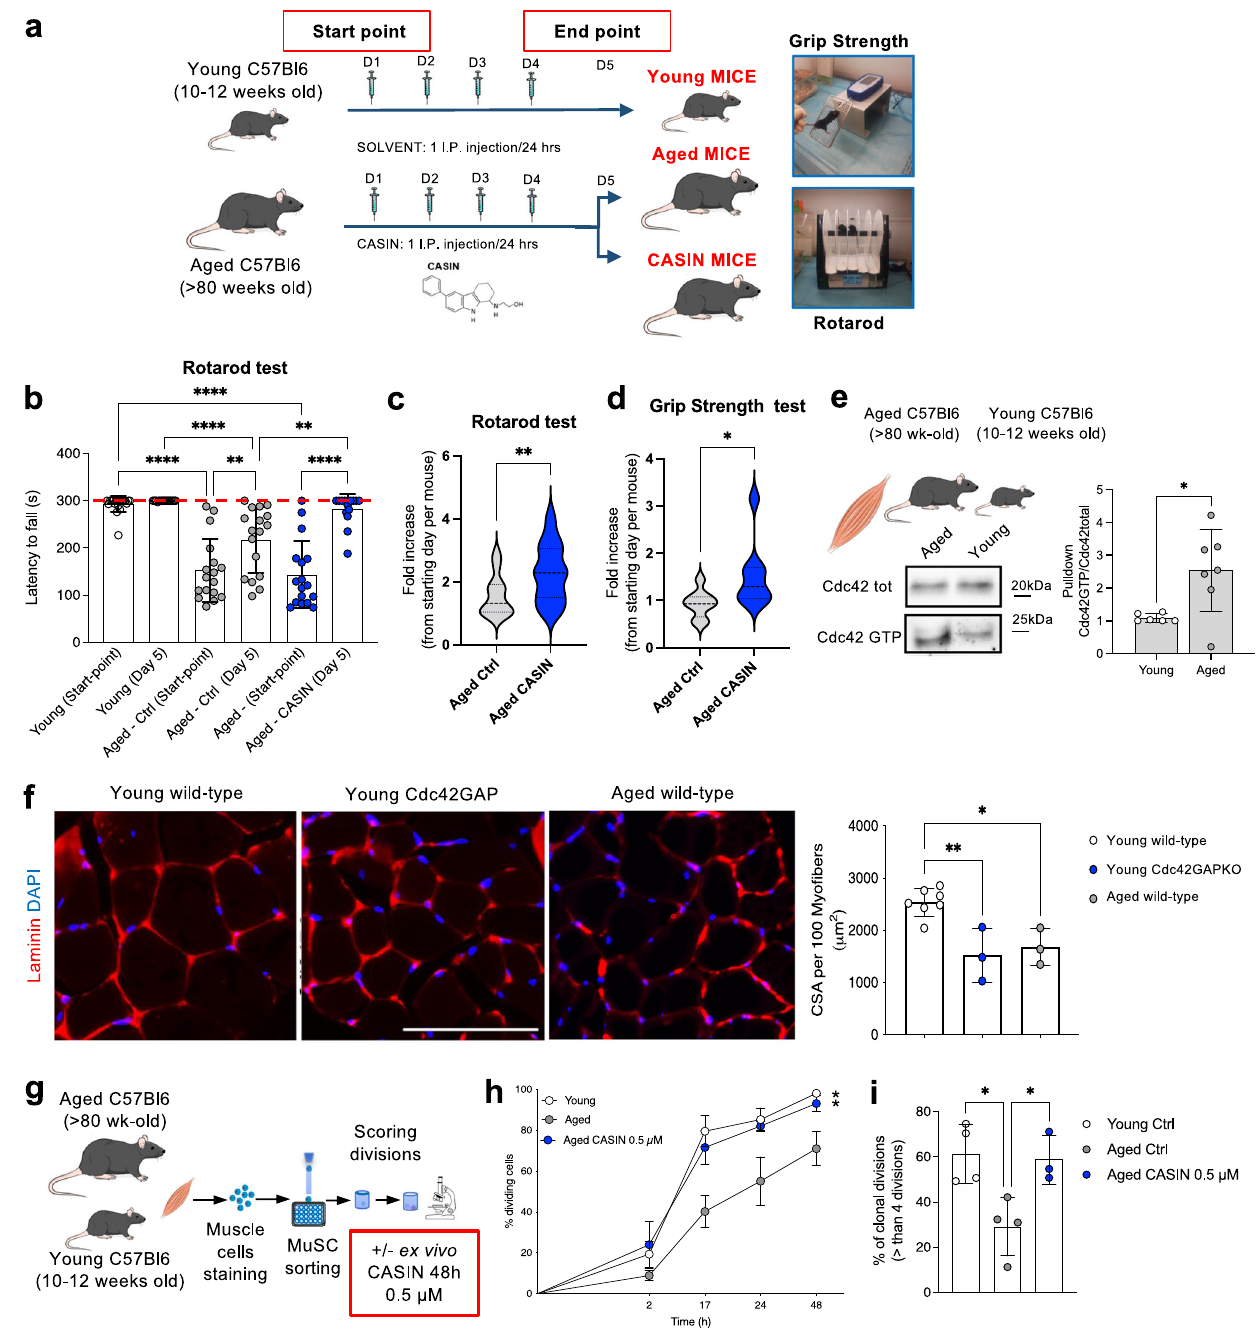
Fig. 1 Systemic inhibition of Cdc42 activity improves aged mouse fi tness. a Experimental design for the fi tness training combined with the CASIN-treatment scheme. b – d Rotarod latency to fall, endurance measurement and grip strength test fold increase (Young, n = 20; Aged/ CASIN, n = 17/15). The red dotted line in panel b represents the end of the experimental recording time (300 s). e Pulldown Cdc42GTP/Cdc42 total in muscle tissues (Young, n = 6; Aged, n = 7). All blots derive from the same experiment and were processed in parallel. f Representative histological analysis of skeletal muscle sections and CSA quanti fi cation. Scale bar, 300 µm. g Experimental scheme for single MuSC growth kinetics. h Growth curve of single MuSCs from young, aged and CASIN mice ( n = 3). i Quanti fi cation of single MuSC clonal divisions on day 6 (Young, n = 4; Aged, n = 4; CASIN, n = 3). Columns are mean ± SD. * P < 0.05, ** P < 0.01, *** P < 0.001, and **** P < 0.0001; one-way ANOVA, multiple comparison with Tukey test for b , c ; t -test for d – f ; Dunnett ’ s vs aged for h , i . Source data are provided as a Source Data fi le. Mouse cartoon: CreativeBucket:stock.adobe.com. Muscle cartoon: